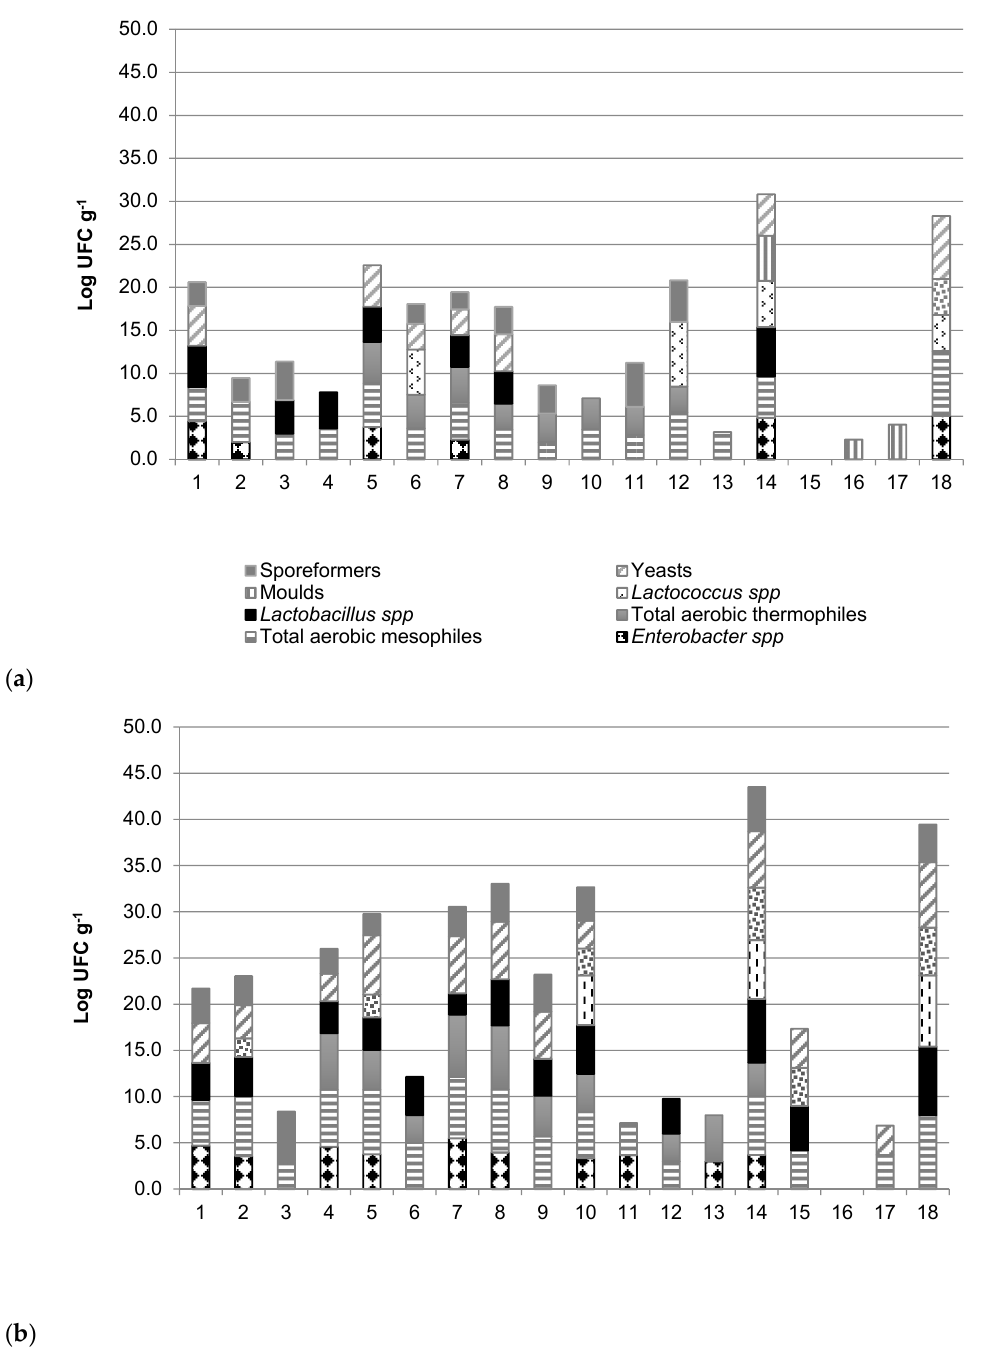
Figure 1. Levels of the main microorganisms groups in beans ( a ) and shells ( b ) of Colombian Criollo cocoa samples (after fermentation and drying, step T1).